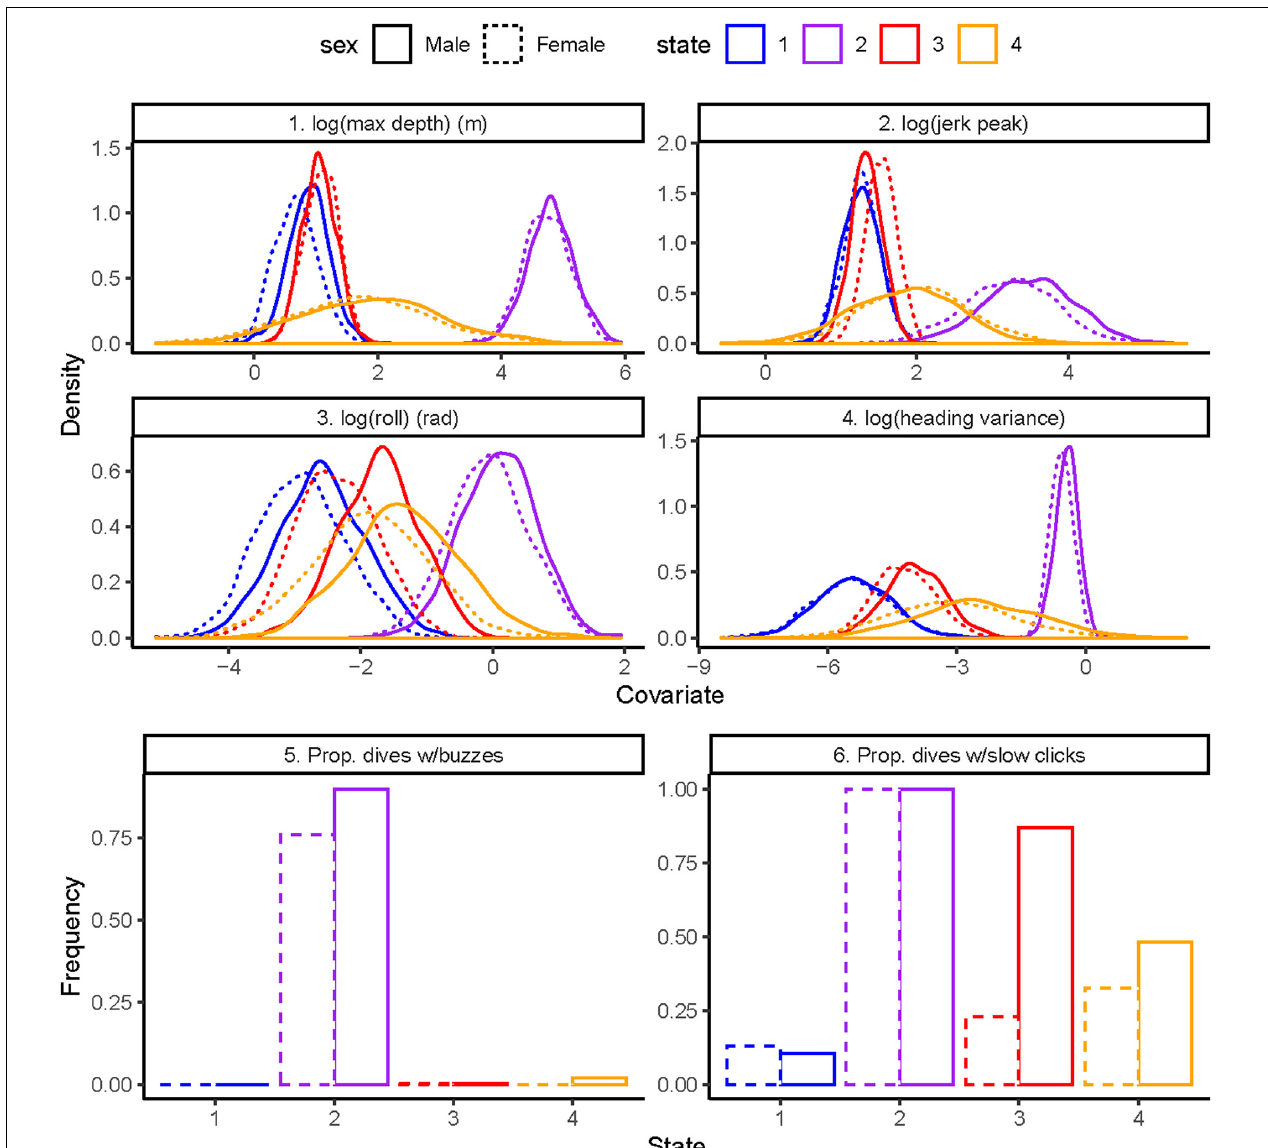
FIGURE 1 | State-dependent distributions of the best model by sex: 1. Log maximum depth in meters (top left), 2. Log standardized jerk peak (top right), 3. Log absolute roll in radians (middle left), 4. Log heading variance (middle right), 5. Proportion of dives with buzzes (bottom left), 6. Proportion of dives with slow clicks (bottom